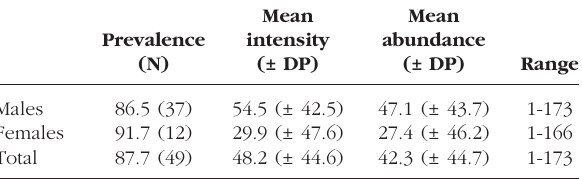
Table I. – Prevalence (%), mean intensity, mean abundance and range of infestation by Hannemania sp. larvae in individuals of the